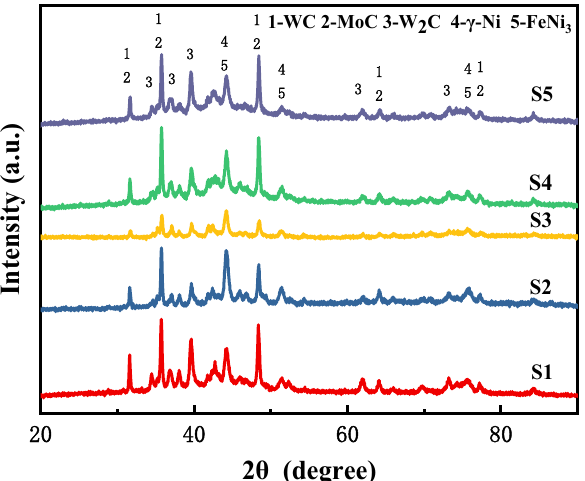
Figure 4: XRD Pattern of the Ni – WC